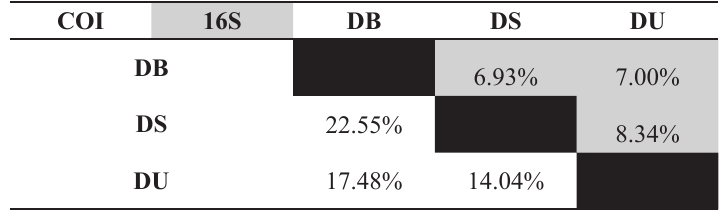
Table 3. Estimates of Evolutionary Divergence over Sequence Pairs between Groups. The number of base differences per site averaging over all sequence pairs between groups are shown. DB = Sechelleptus arborivagus sp. nov. (DB2–DB4 in COI dataset, DB1–DB4 in 16S dataset); DS = Sechelleptus variabilis VandenSpiegel & Golovatch, 2007 (DS1–DS3); DU = Sechelleptus sp. (DU1). Molecular analyses